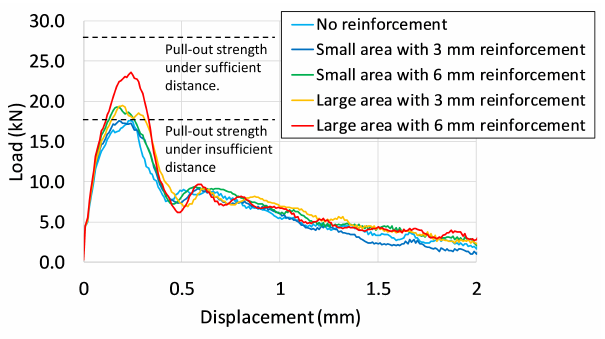
Figure 31. Load-displacement relationships with PCM reinforcement